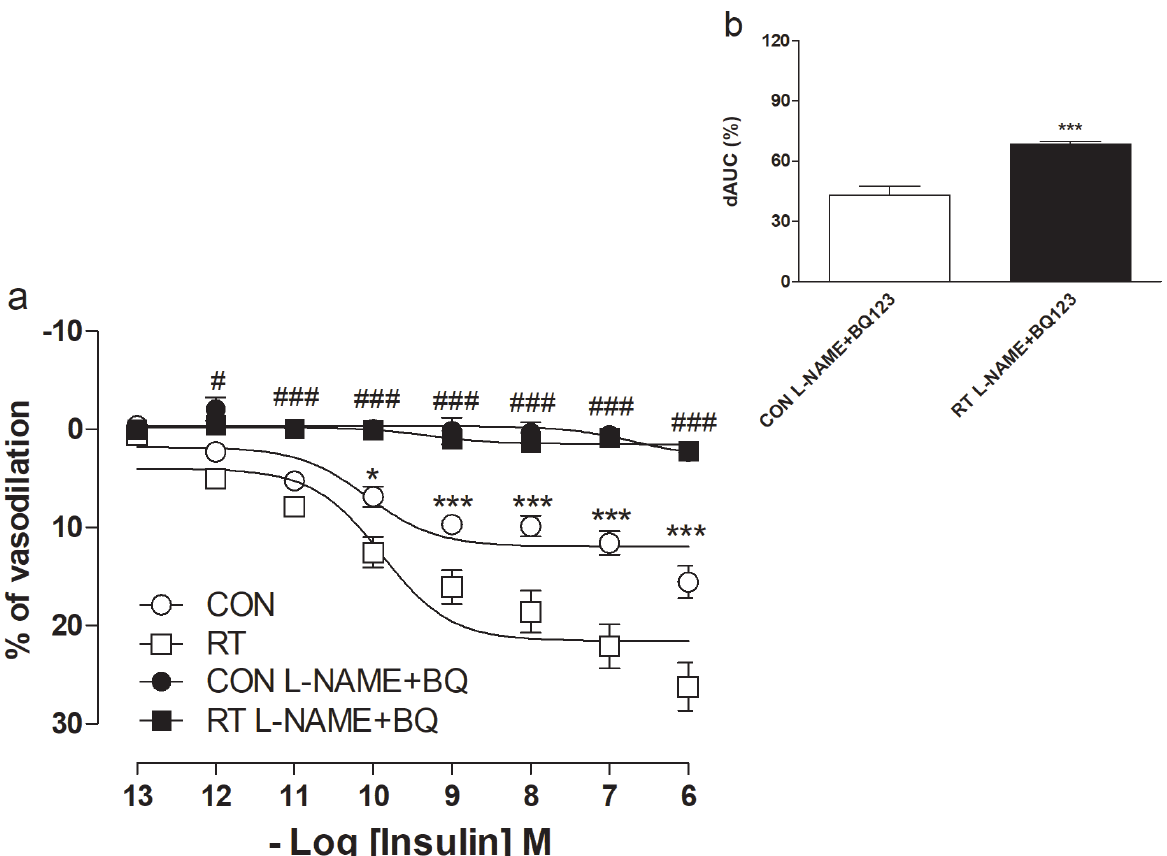
Figure 4. Concentration-response curves for insulin (10 -13 - 10 -6 M) in isolated rings of the rat superior mesenteric artery with functional endothelium and pre-contracted with Phe (1µM). (a) Rings obtained from animals of the Control group (CON) and Resistance training (RT) in the absence and presence of L-NAME + BQ123. (b) Variation of the area under the curve (dAUC) between the presence and absence of L-NAME + BQ123. The data represent the mean ± SEM for 8 - 10 experiments for each group. A: * p < 0.05, *** p < 0.001 CON vs. CON L-NAME + BQ123. # p < 0.01, ### p < 0.001 RT vs. RT L-NAME + BQ123; B: *** p < 0.001 CON L-NAME + BQ123 vs. RT L-NAME +